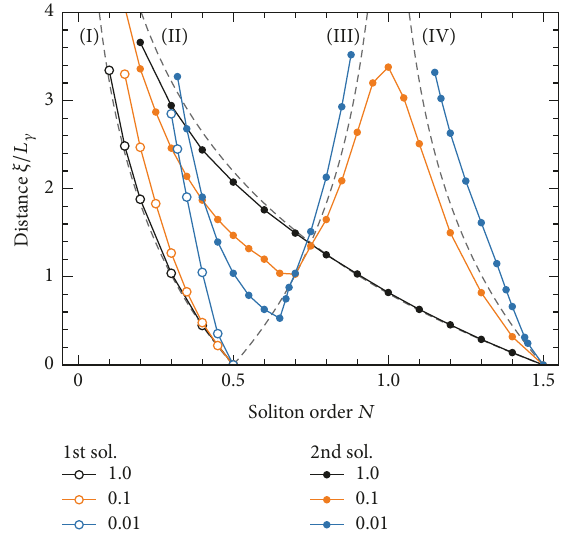
Figure 11: Propagation distance until a new soliton is generated. Distance is normalized to 𝐿 𝛾 ; therefore, values also represent the accumulated gain up to that point. Parameter: 𝛾 as indicated. For reference, auxiliary lines (I–IV) indicate certain limiting cases; see